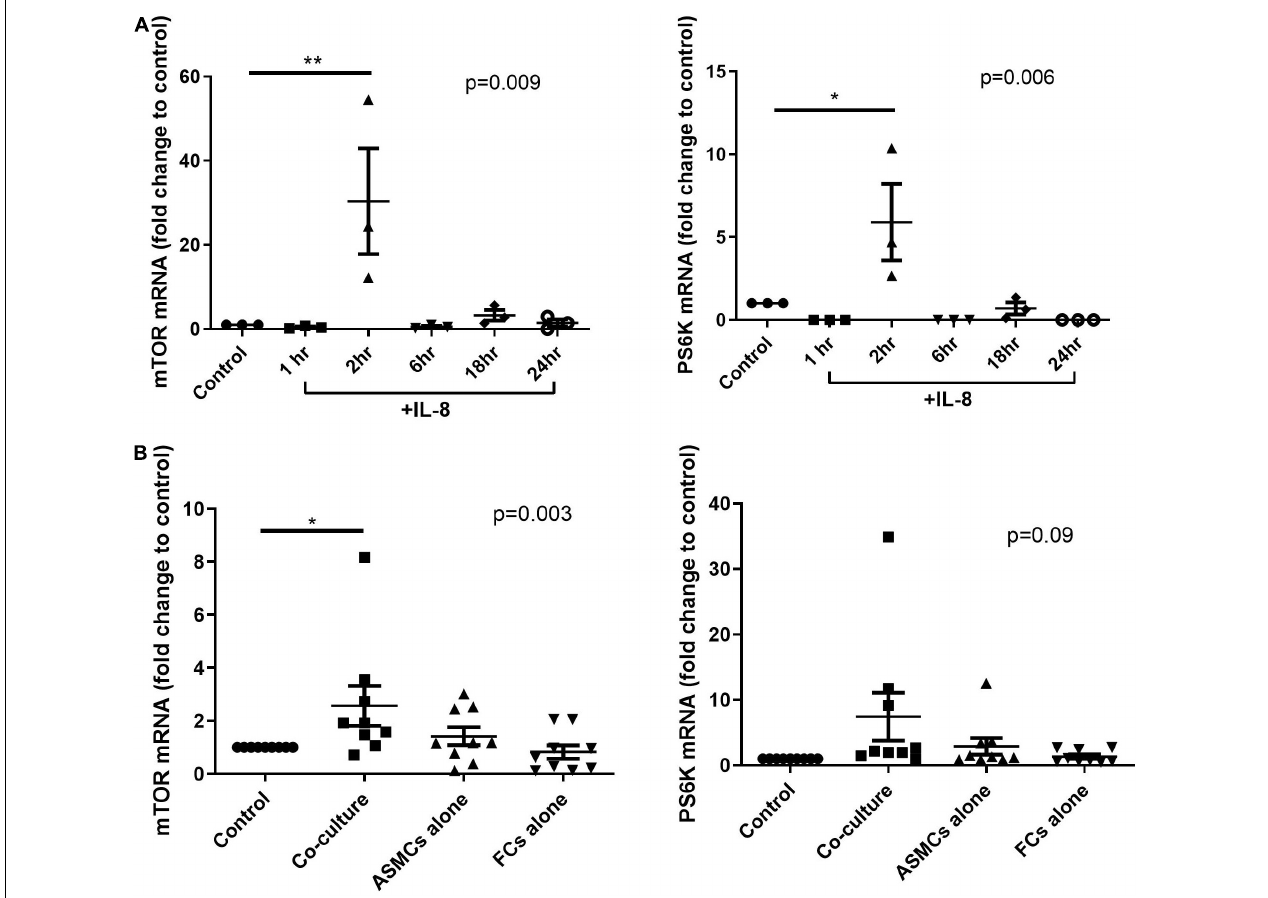
FIGURE 5 | mRNA expression of mTOR or PS6K in ASMCs after (A) IL-8 stimulation for 1, 2, 6, 18, and 24 h or (B) treatment with diluted condition medium co-cultured with fibrocytes from asthmatic patients, ASMCs cultured alone, or fibrocytes cultured alone for 2 h. PBS as the control. * p < 0.05, One-way ANOVA with Tukey’s multiple comparison test ( n = 3 ∼ 9). ** P <